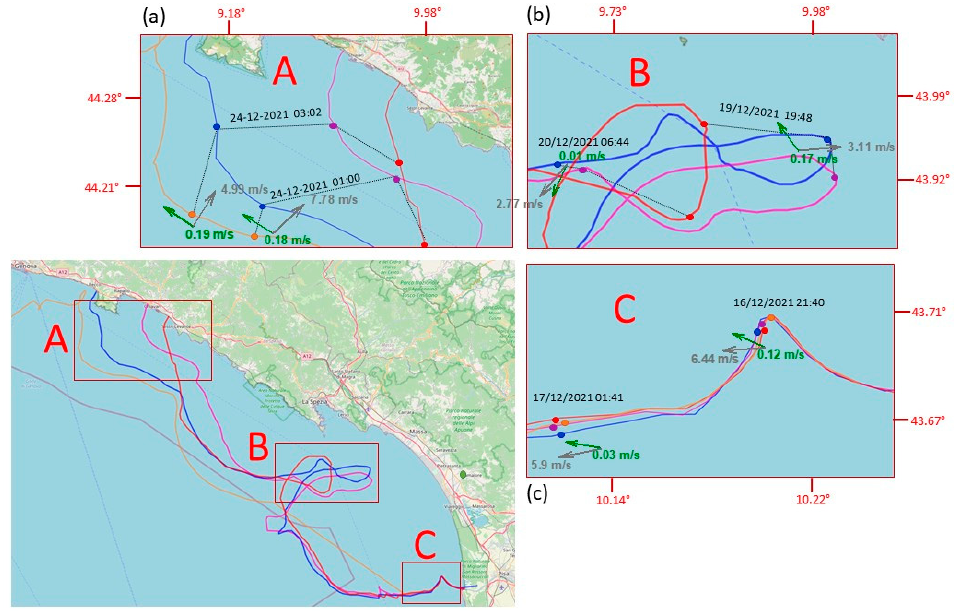
Figure 8. December 2021 launch with four MLTs (time is expressed according to CET). Trajectories correspond to L2T1 (blue line, bottle-shaped); L3T1 (violet line, bottle shaped); L4T3 (red line, table- shaped), L4T1 (orange line, table-shaped), as reported in Table 1. Boxes ( a ), ( b ) and ( c ) are zooms on the three coastal areas A, B and C highlighted in the full picture. The green and gray arrows in these panels represent current and wind direction, respectively. The associated intensities are reported aside with the same